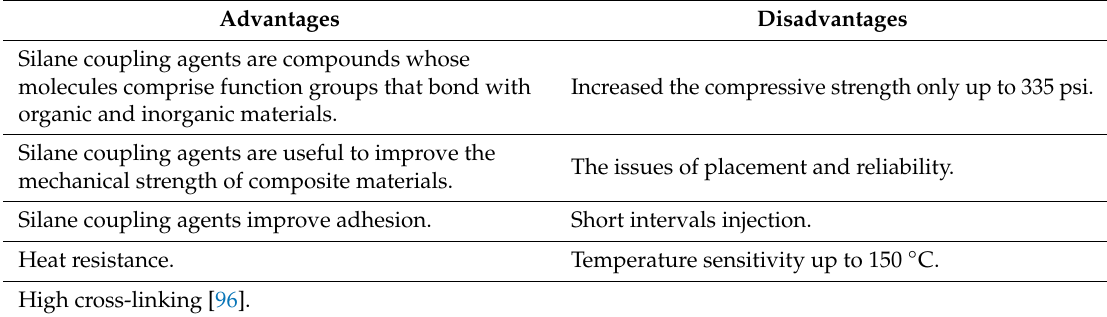
Table 16. Advantages and disadvantages of hydrolysate or precondensate consolidation agent method. Advantages Disadvantages Increased the compressive strength only up to 335 psi.